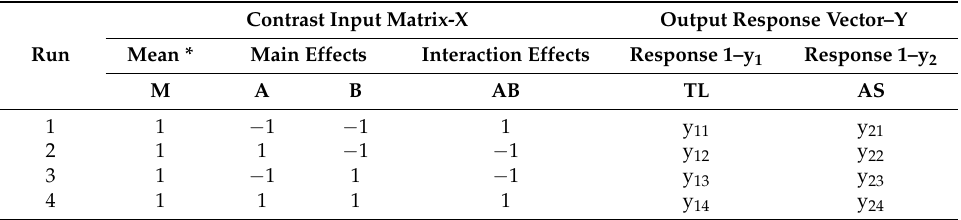
Table 6. Setup of the contrast matrix for the whole